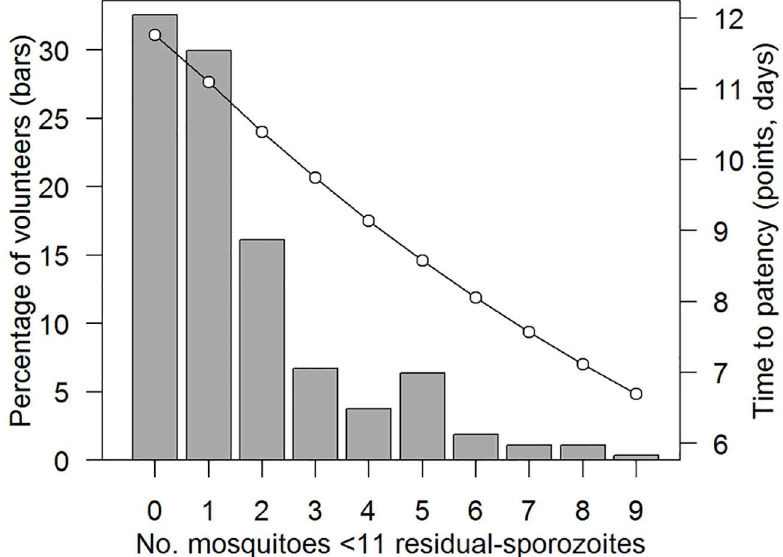
Fig 3. The frequency and impact on the time to patency in humans of mosquito bites with (cid:20) 10 residual-sporozoites. Grey bars show how many volunteers receivedbites from mosquitoeswith (cid:20) 10 salivary gland sporozoites. Black dots (and line) show model predictionsfor the mean time to patency for volunteers with different number of ( (cid:20) 10) bites. As the impact of the lightly infected bites will dependon the numberof residual-sporozoites in the bites the volunteerreceived,in this exampleall volunteerreceive 5 bites from mosquitoeswith 101–1000residual-sporozoitesin addition to the extra mosquitobites with (cid:20) 10 residual-